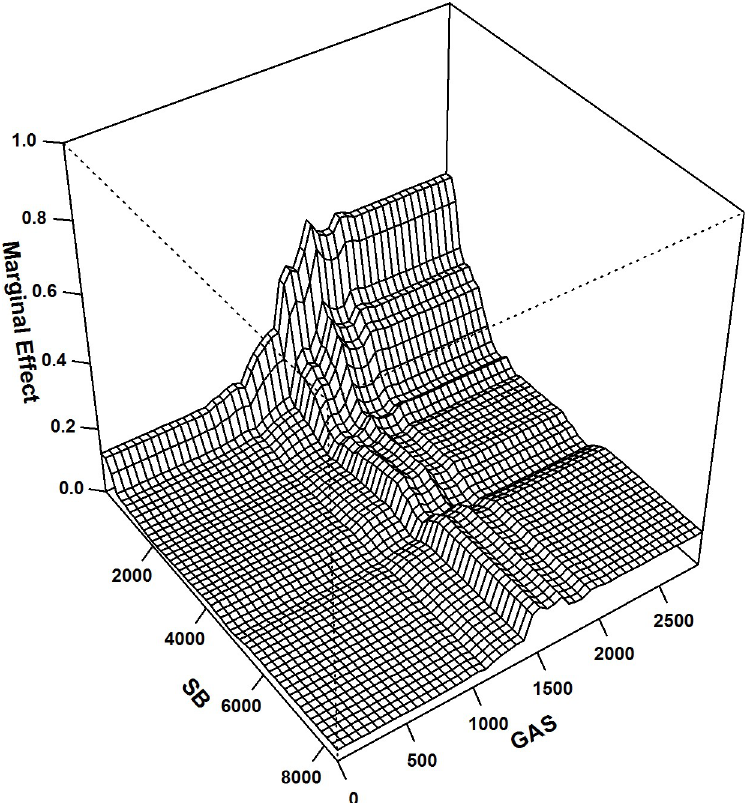
Fig 5. BRT 2-way: Interaction plot for distances to the edges of special biotas and the edges of green areas around settlement; the third most important interaction in the BRT 2-way model; interaction size = 0.51.